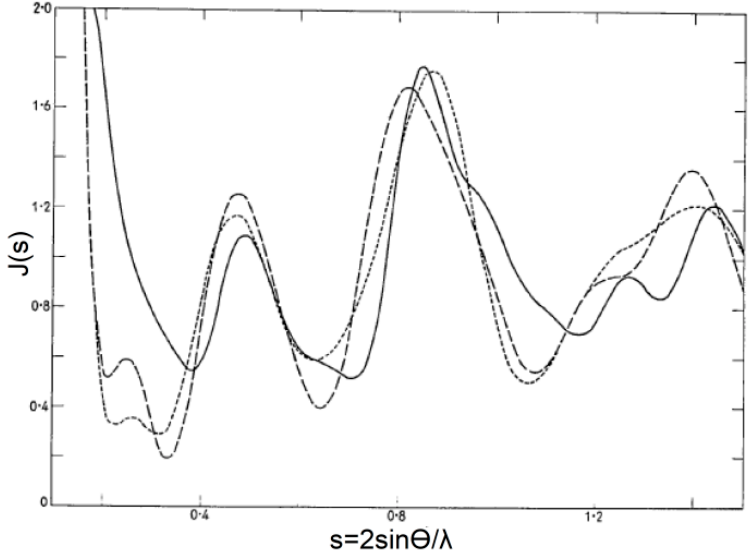
Figure 13. Calculated X-ray scattering intensities of a graphite-like layer (solid line), a cubic diamond-like lattice (dashed line), and a hexagonal diamond lattice (dotted line), each containing 26 atoms. Reproduced with permission from Ergun and Tiensuu [57]. Copyright International Union of Crystallography, 1959.